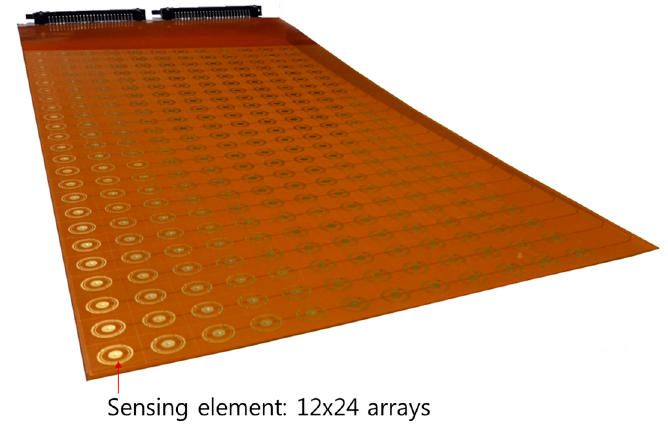
Figure 8. Configuration of the prototype sensor.